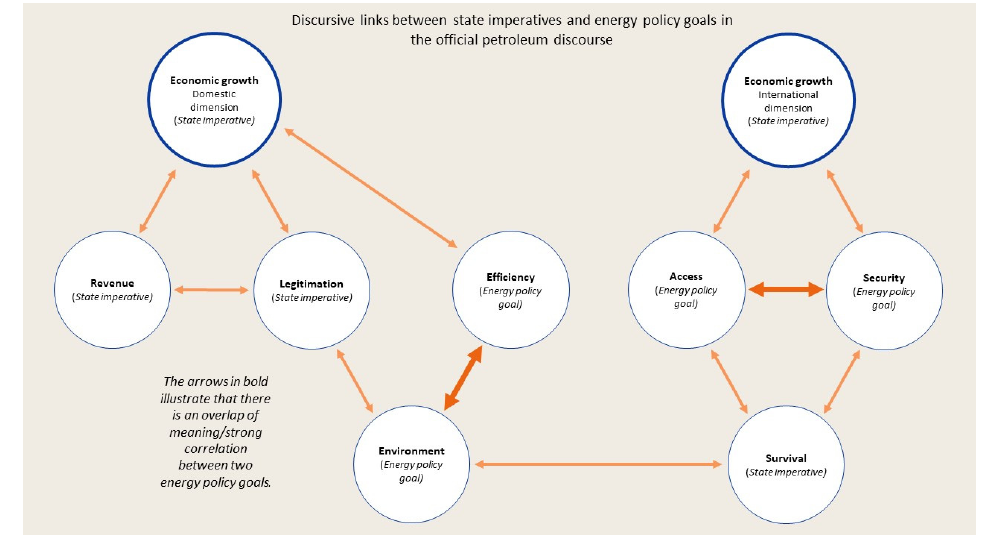
Figure 2. Discursive links in the official petroleum discourse between state imperatives and energy policy goals. The figure illustrates how the state imperative of economic growth is the most dominant, with two dimensions. In the domestic dimension, efficient petroleum production is linked to the state imperative of revenue, the legitimation imperative (through creating welfare and jobs) and the energy policy goal on environment. In the international dimension, global demand for clean energy access and security is linked to Norwegian petroleum production, maintaining a space for Norwegian petroleum in an increasingly carbon-constrained world (securing the state imperative of survival). In the following, we exemplify and show empirically how these framings are used in the official petroleum discourse, and how the discursive links between the state imperatives and the energy policy goals appear in the official documents as shown in Figure 2.